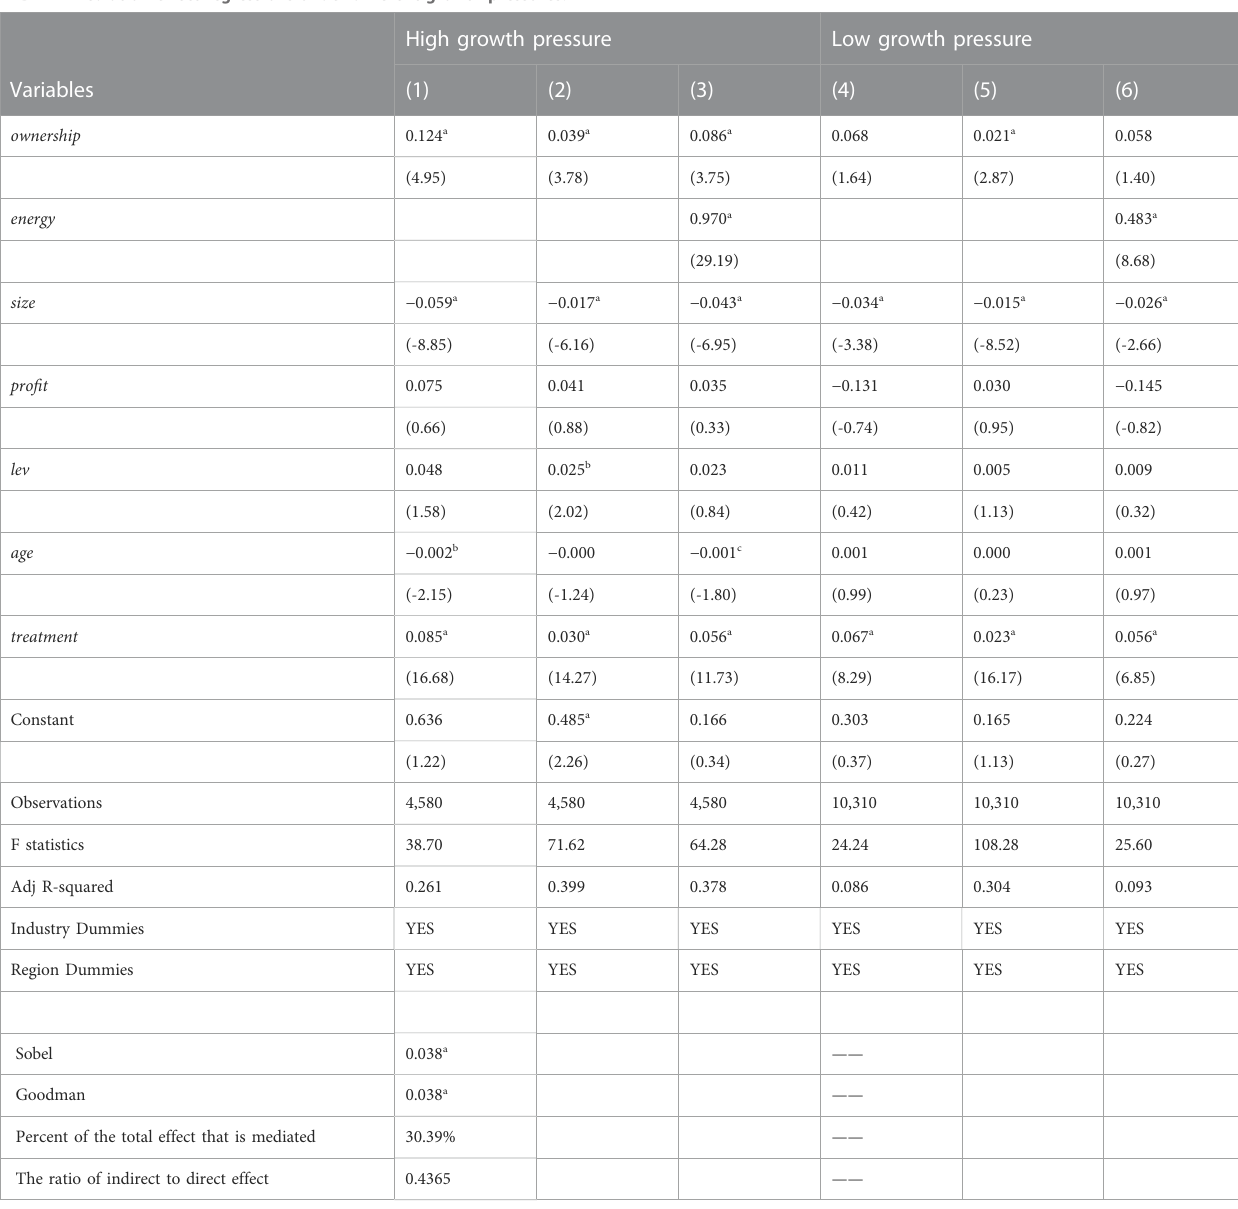
TABLE 4 Mediation effect regressions under different growth